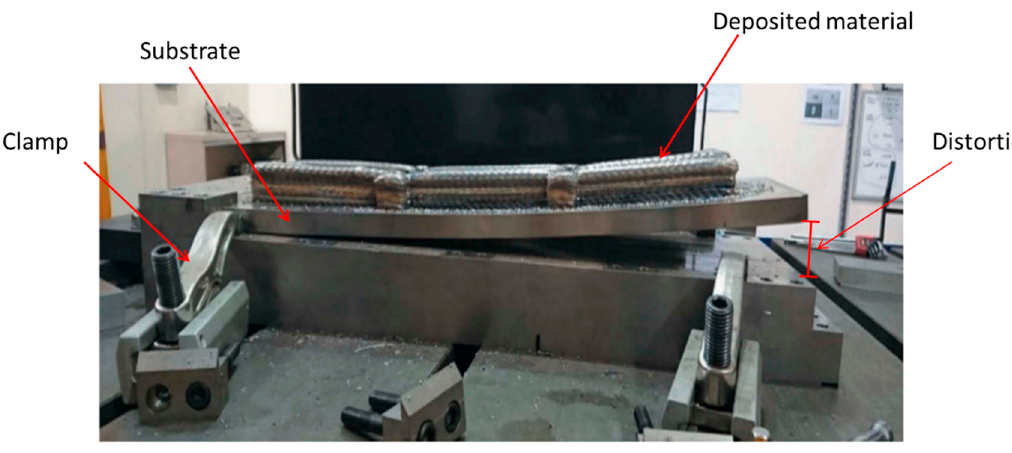
Figure 31. Distortion of a WAAM part (adapted from [148]).